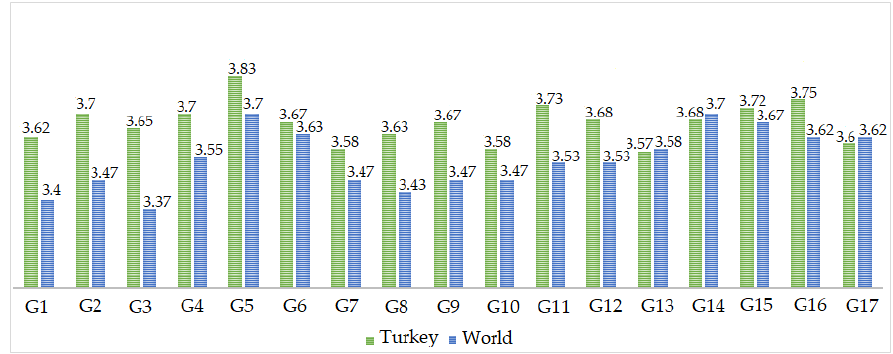
Figure 1 . Pre-service teachers’ status of caring about the UN 2030 SDG for Turkey and for the world. As shown in Figure 1, the goal cared about most for Turkey is G5 (Gender equality) with a mean score of 3.83 and the one cared about least is G13 (Climate action) with a mean score of 3.57. For the world, on the other hand, the goals cared about most are G5 (Gender equality) and G14 (Life below water) and the one cared about least is G3 (Good health and well-being) with a mean score of 3.37. When a comparison is made between caring about SDG for Turkey and caring about SDG for the world based on each goal, it is seen that G1 (No poverty), G2 (Zero hunger), G3 (Good health and well-being), G4 (Quality education), G5 (Gender equality), G6 (Clean water and sanitation), G7 (Affordable and clean energy), G8 (Decent work and economic growth), G9 (Industry, innovation and infrastructure), G10 (Reduced inequalities), G11 (Sustainable cities and communities), G12 (Responsible consumption and production), G15 (Life on land), and G16 (Peace, justice and strong institutions) are cared about more for Turkey than for the world. On the other hand, the pre-service teachers care about G13 (Climate action), G14 (Life below water), and G17 (Partnerships for the goals) more for the world than for Turkey. The biggest difference between the mean scores for caring about the goals for Turkey and for the world is in G3 (Good health and well-being) in favour of Turkey. The smallest difference between the mean scores for caring about the goals for Turkey and for the world is in G13 (Climate action) in favour of the world.